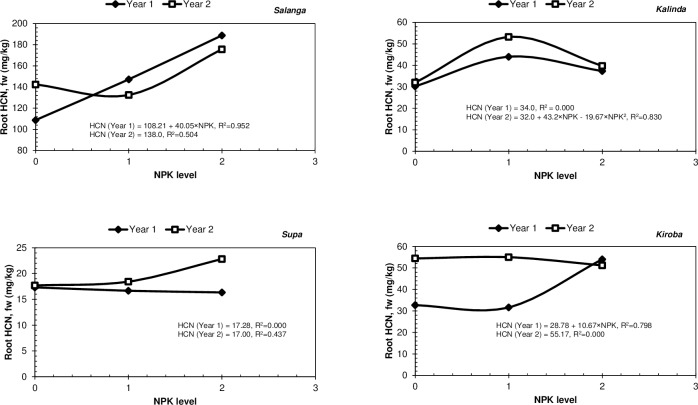
Models of HCN responses to increased NPK fertiliser application for each cassava variety in the field experiments in Years 1 and 2.Note that an ordinal scale was used to represent the fertiliser treatments and that; 0 = (N0P0K0), 1 = N1P1K1 and 2 = N2P2K2. Where; N0P0K0 = no fertiliser; N1P1K1 = 50 kg N + 10 kg P + 50 kg K /ha; N2P2K2 = 100 kg N + 25 kg P + 100 kg K /ha. Note that the sole K treatment (N0P0K1) has not been included in these analyses.